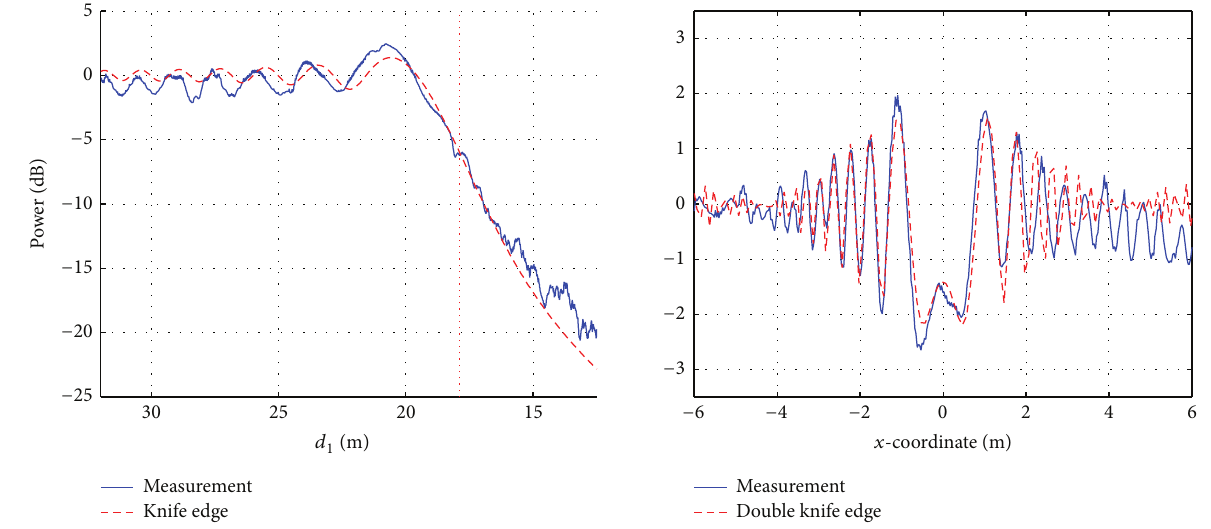
Figure 16: Power variation of the direct signal due to diffraction on a house front (modeled by a knife edge) and a lamp post (modeled by double knife edge) in the urban city center environment with the Zeppelin at 40 ∘